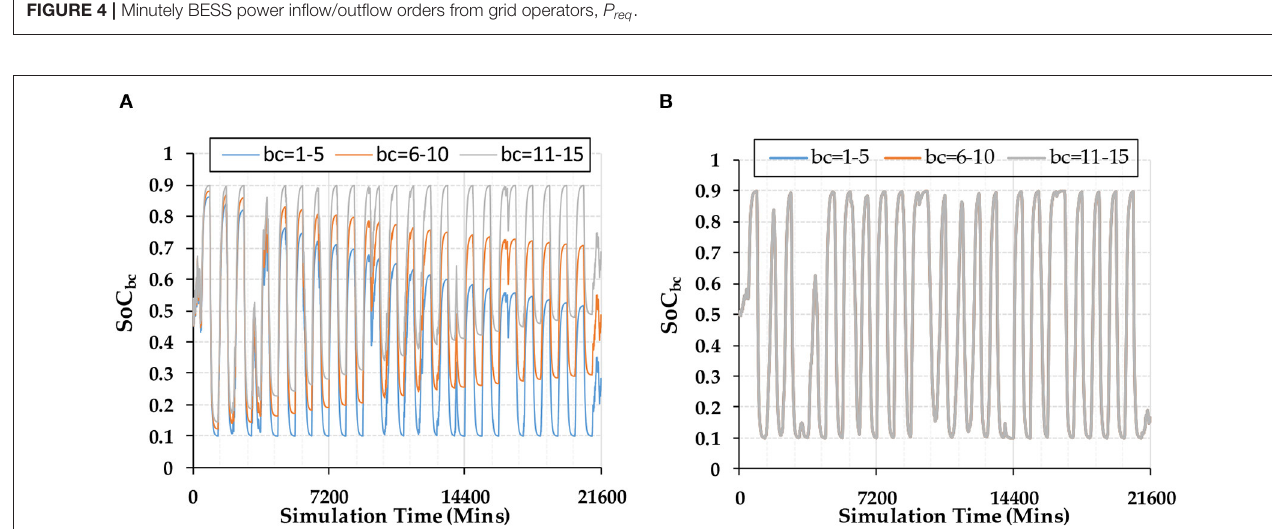
FIGURE 5 | SoC outputs of Sc-4 (A) and Sc-5, 6 (B) in 15 days.